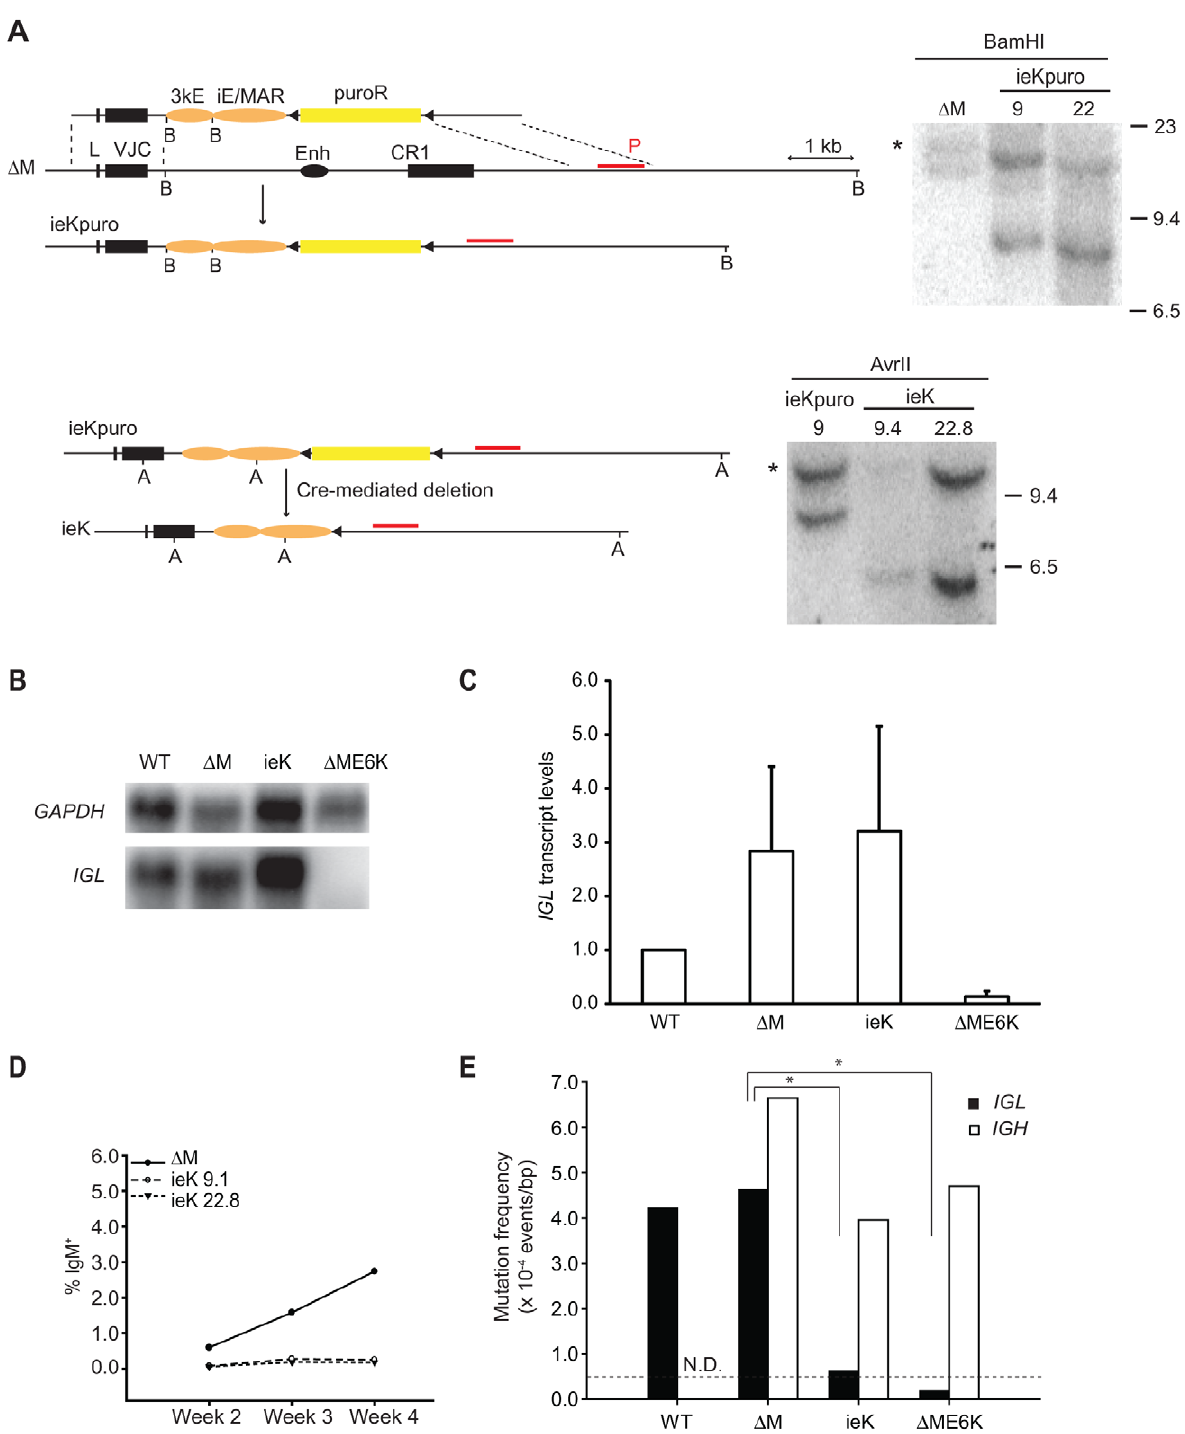
Figure 4. Analysis of double Ig k enhancer knock-in DT40 cells. A) Gene-targeting scheme with the murine iE/MAR and 3kE shown as orange ovals, for a detailed description of all elements see Fig. 1. The restriction sites are marked (A: AvrII, and B: BamHI), and the red line above the locus denotes the Southern blot probe (P). The asterisk in each Southern blot marks the band that originates from the non-rearranged allele. B) Northern Blots were run using 10 m g of total RNA of wild-type (WT) DT40 cells and each of the indicated cell lines, and hybridized sequentially with IGL and GAPDH probes. One representative example is shown. C) Normalized steady-state transcript levels of IGL were determined by Northern blots analysis. The level in wild-type cells is arbitrarily set to one, and an average of at least four data points obtained for each genotype is shown. D) Average percentages of IgM + cells (twelve subclones per indicate clone) at each time point areshown for each genotype. E) Mutation event frequencies in the IGL (filled bars) and IGH (open bars) loci were determined by sequencing of the VJ or VDJ exon from two independent subclones of the ieK DT40 cells after four weeks of continuous culture. The data for wild type (WT) and D ME6K were obtained from [13]. Asterisks indicate p , 0.005 in a Student’s t-test.